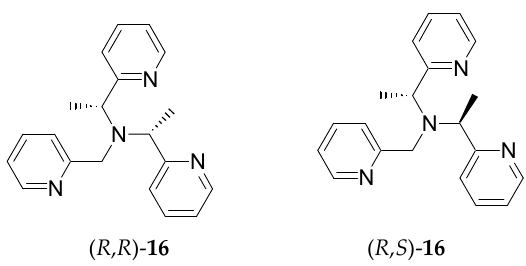
Figure 12. Bis-chiral TPA-analogs that can modulate lanthanide fluorescence.